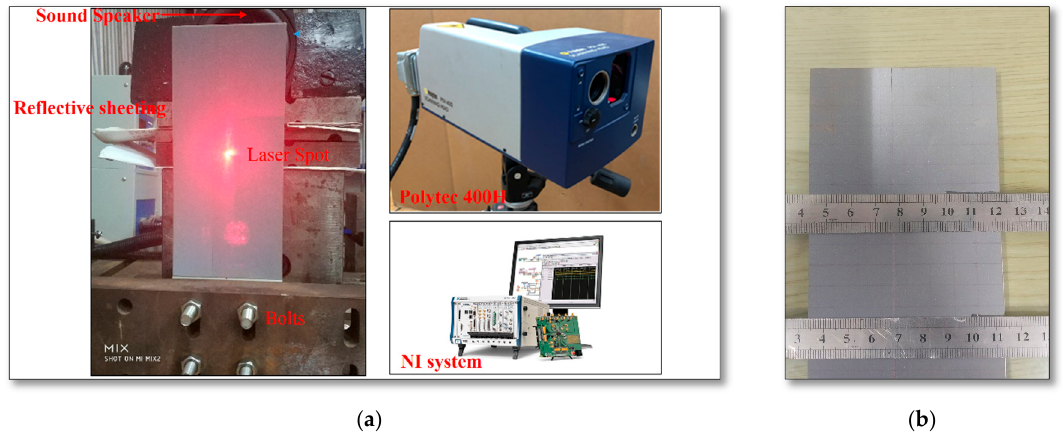
Figure 6. The test configuration. ( a ) The test configuration, scan head of laser doppler vibrometer (LDV) and National Instruments (NI) and PCI extensions for Instrumentation (PXI) system. ( b ) Test piece of multi cracks.